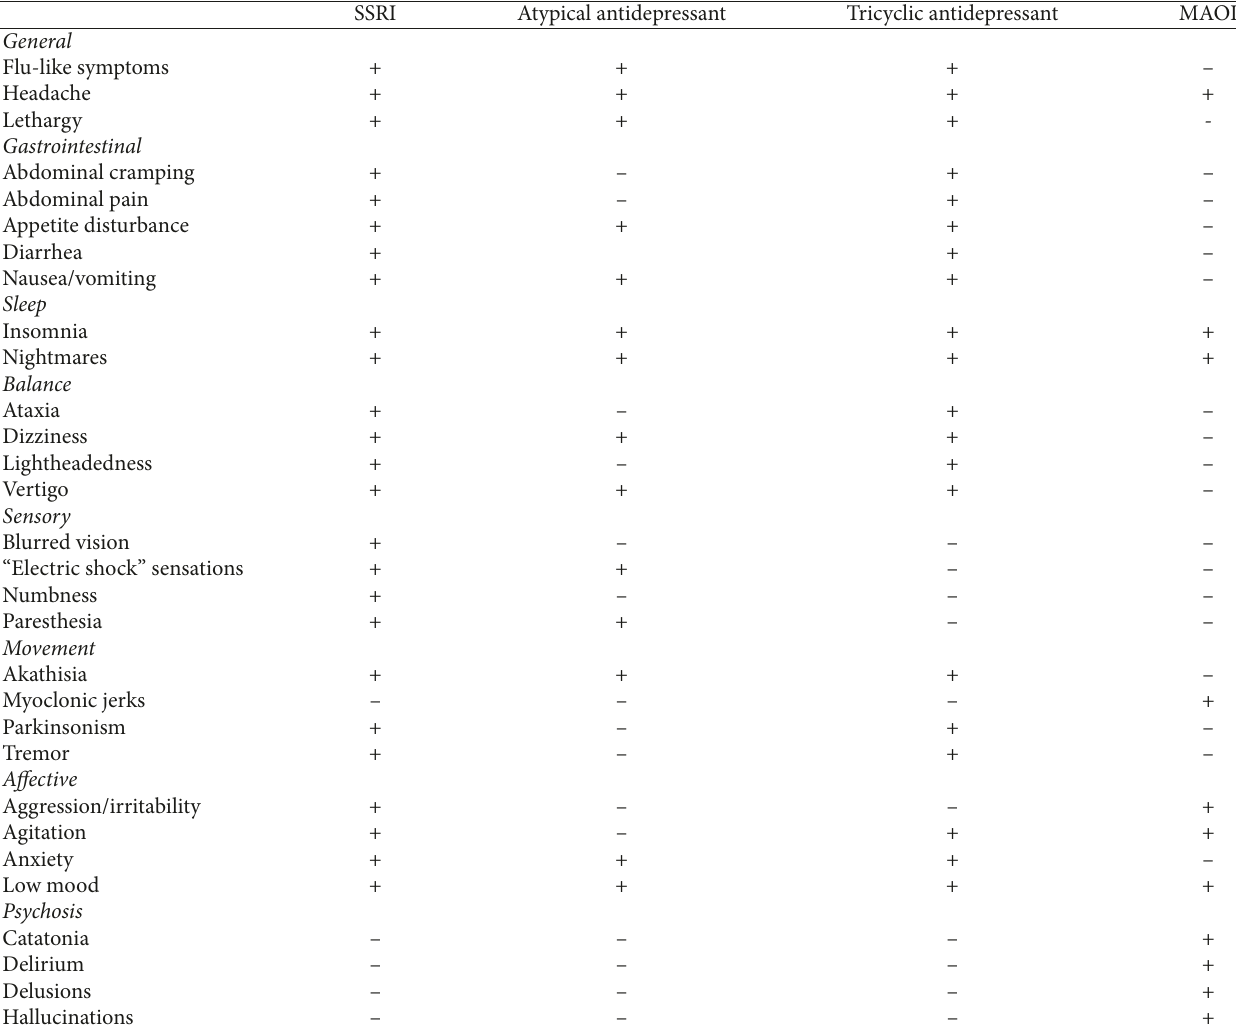
Table 2: Signs and symptoms of antidepressant discontinuation syndrome. SSRI Atypical antidepressant Tricyclic